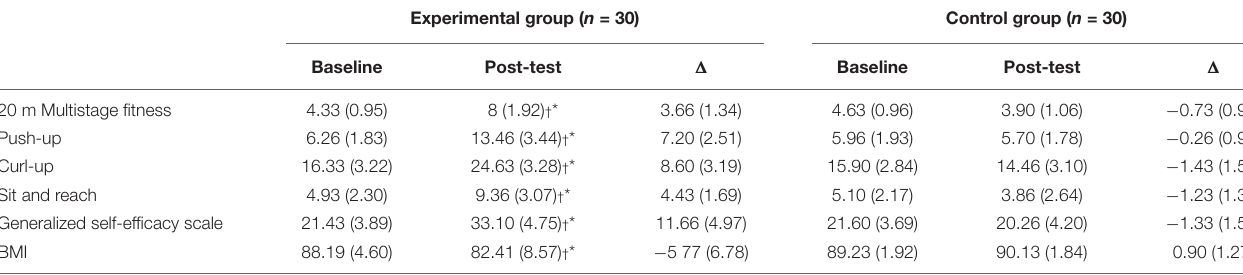
TABLE 2 | Changes after 12-week aerobic exercise